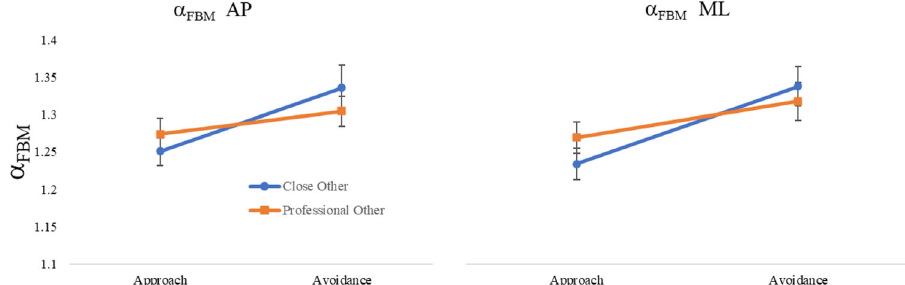
Fig. 4 Results of fractal analysis for postural activity. Mean α FBM of postural activity in the AP ( left ) and ML ( right )